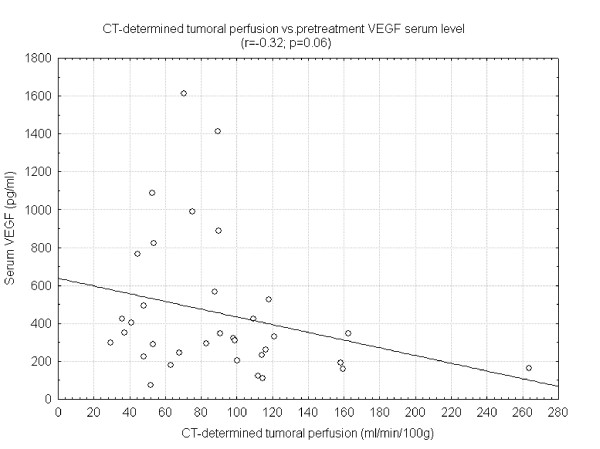
Correlation between CT-determined tumoral perfusion and pretreatment VEGF serum levels. There was a trend for poorer CT-determined tumoral perfusion to correlate with higher pretreatment VEGF serum levels (rS = -0.32, p = 0.06; n = 34).